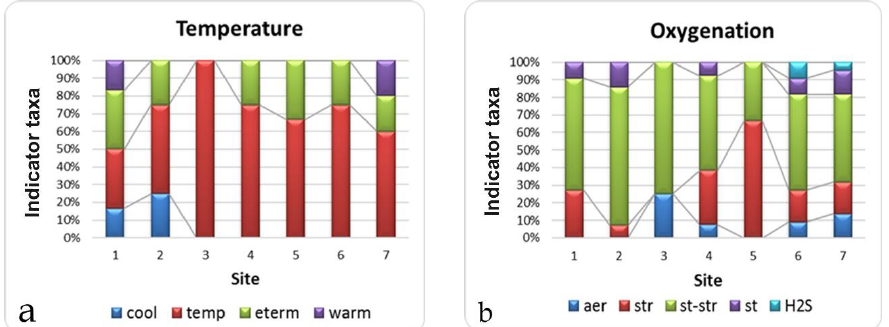
Figure 8. Ecological groups of water temperature preferences ( a ) and oxygenation ( b ) indicators in